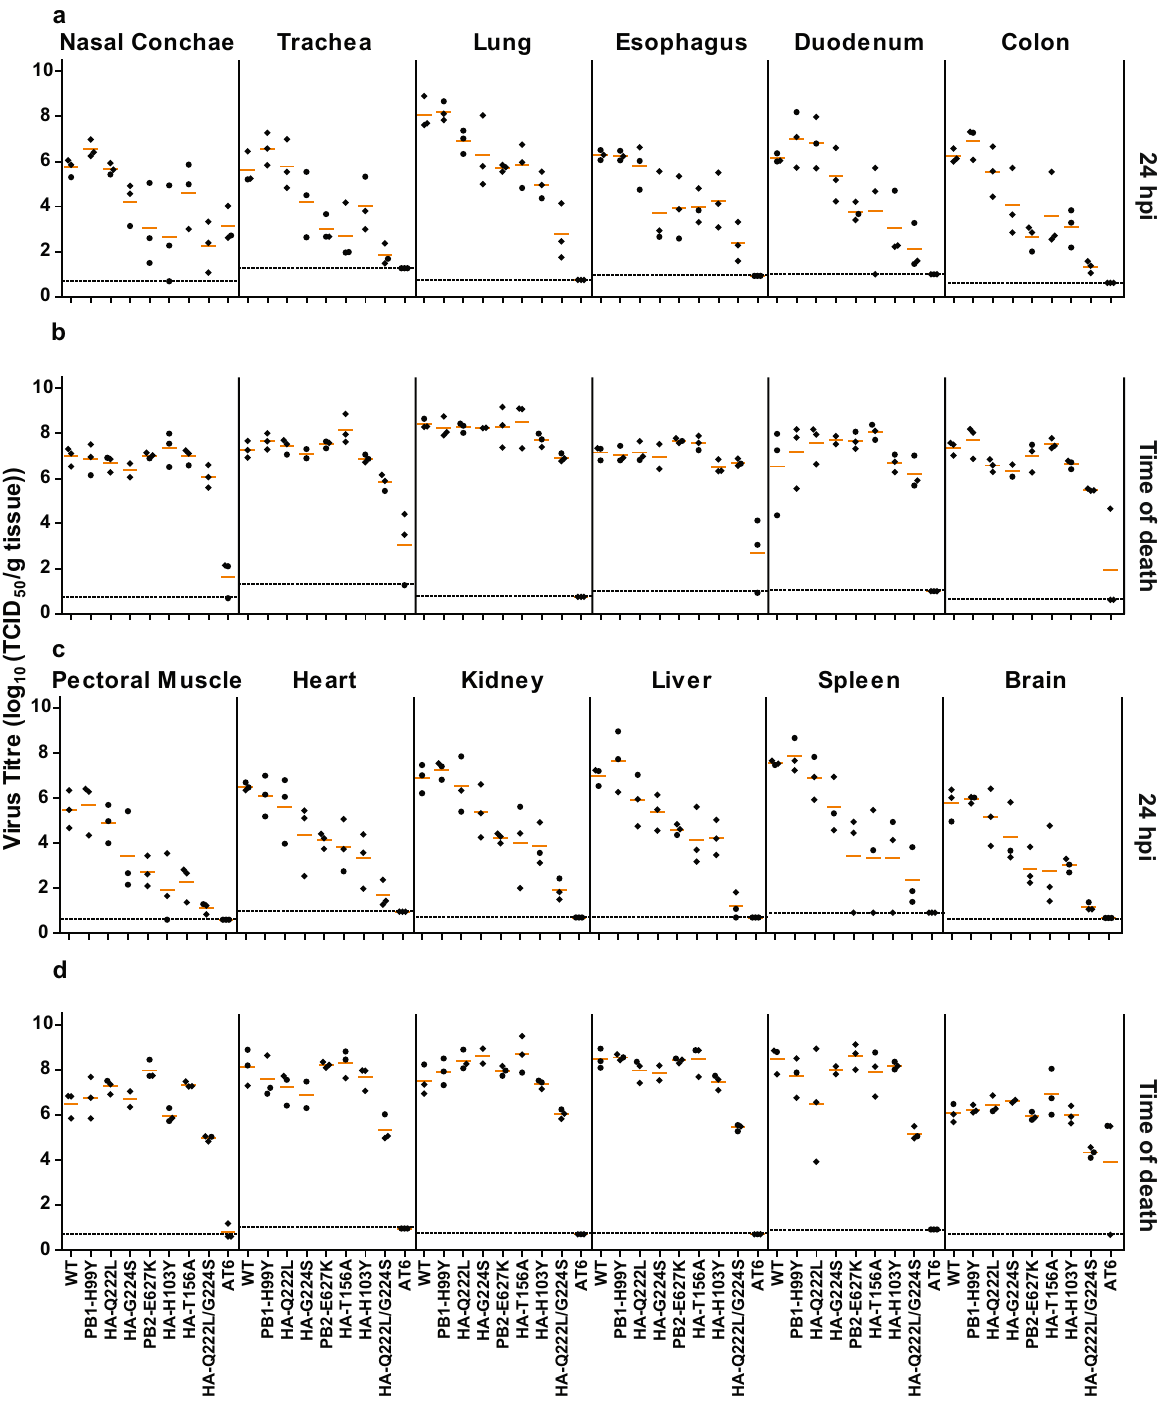
Figure 3. Viral titres in organs of chickens inoculated with mutant viruses. ( a and c ) Individual viral titres at 24 hpi in organs of chickens inoculated with mutant viruses carrying the indicated substitutions. ( b and d ) Individual viral titres at the time of death in organs of chickens inoculated with mutant viruses carrying the indicated substitutions. Lower limits of detection are indicated by the dotted lines. Mean virus titres are indicated by the orange